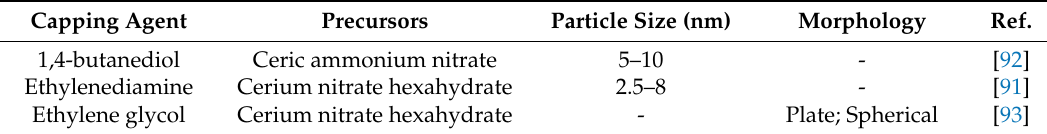
Table 5. Table showing the synthesis of cerium oxide nanoparticles using the solvothermal method. Capping